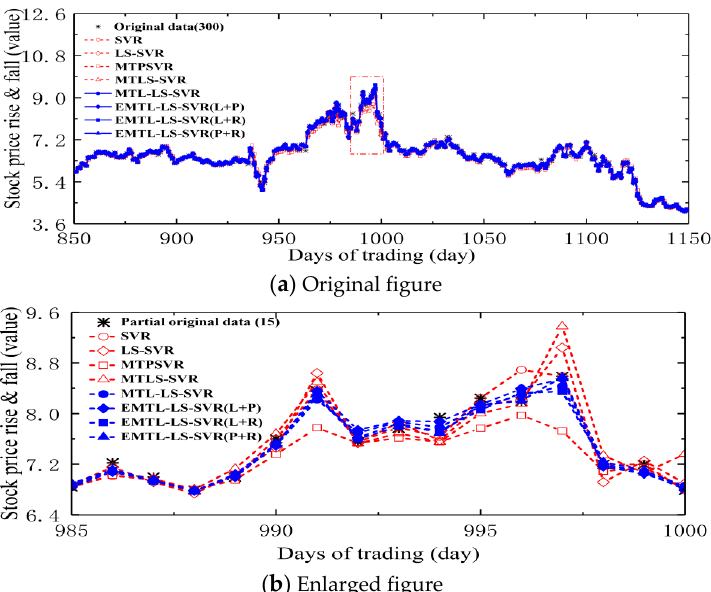
Figure 12. Predictions of different regression models on stock opening price for CCB ( a ) Original figure, ( b ) Enlarged figure.